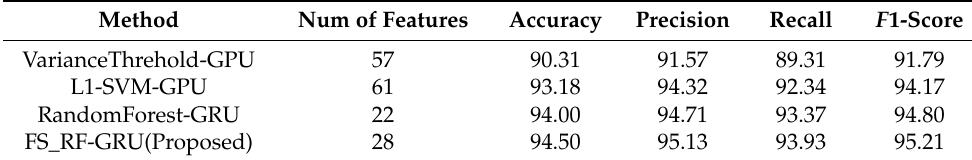
Table 3. Results on the sample 1.